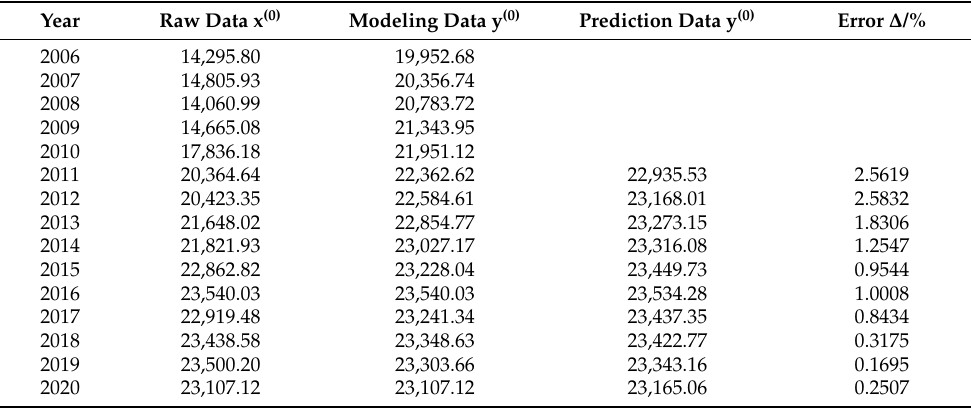
Table A5. Prediction error table of GRPM